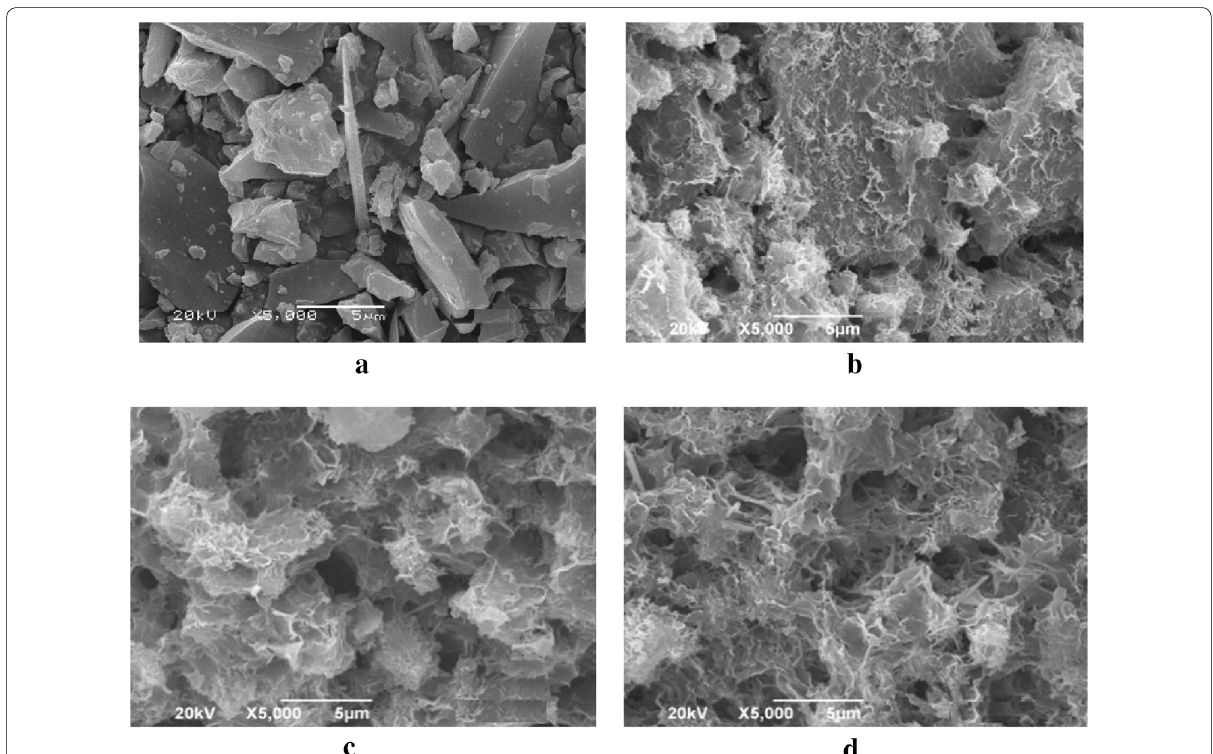
Fig. 7 SEM microstructures of WG-a-30 cement mortar at different curing ages. a Waste glass powder, b curing age of 14 days, c curing age of 28 days, d curing age of 120